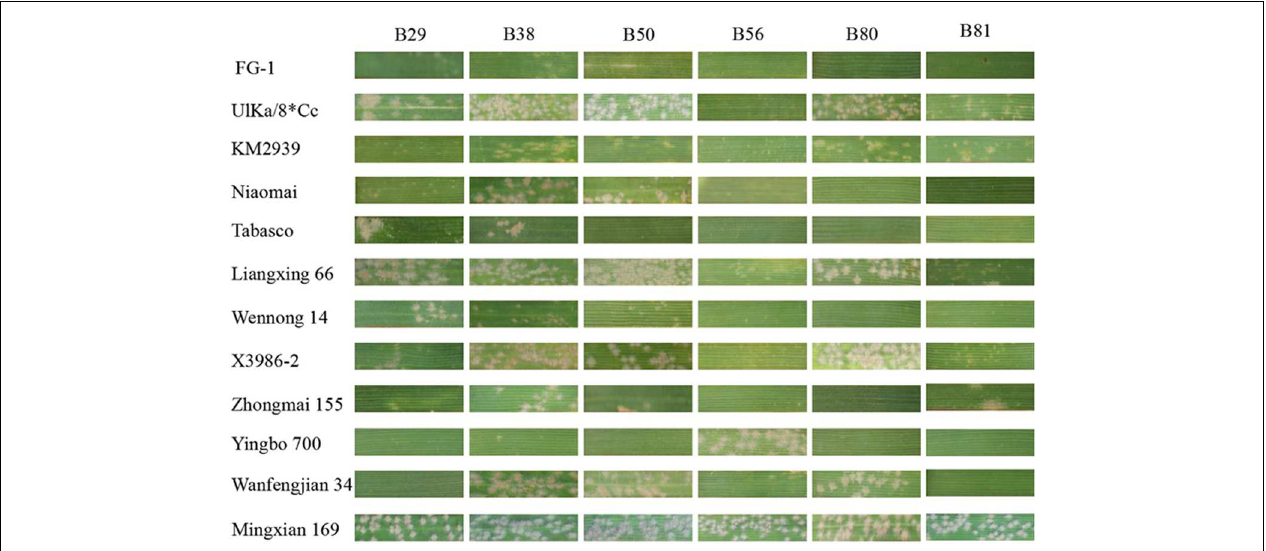
FIGURE 1 | Examples of leaf segment reactions of FG-1 and various wheat genotypes to 6 of 49 Bgt isolates; cv. Mingxian 169 was used as the susceptible control.